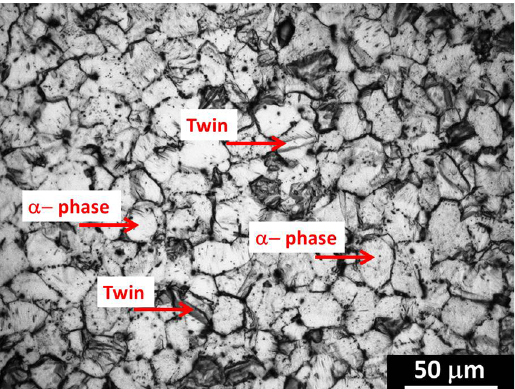
Figure 1. cp-Ti micrograph obtained by OM. Reagent: Kroll